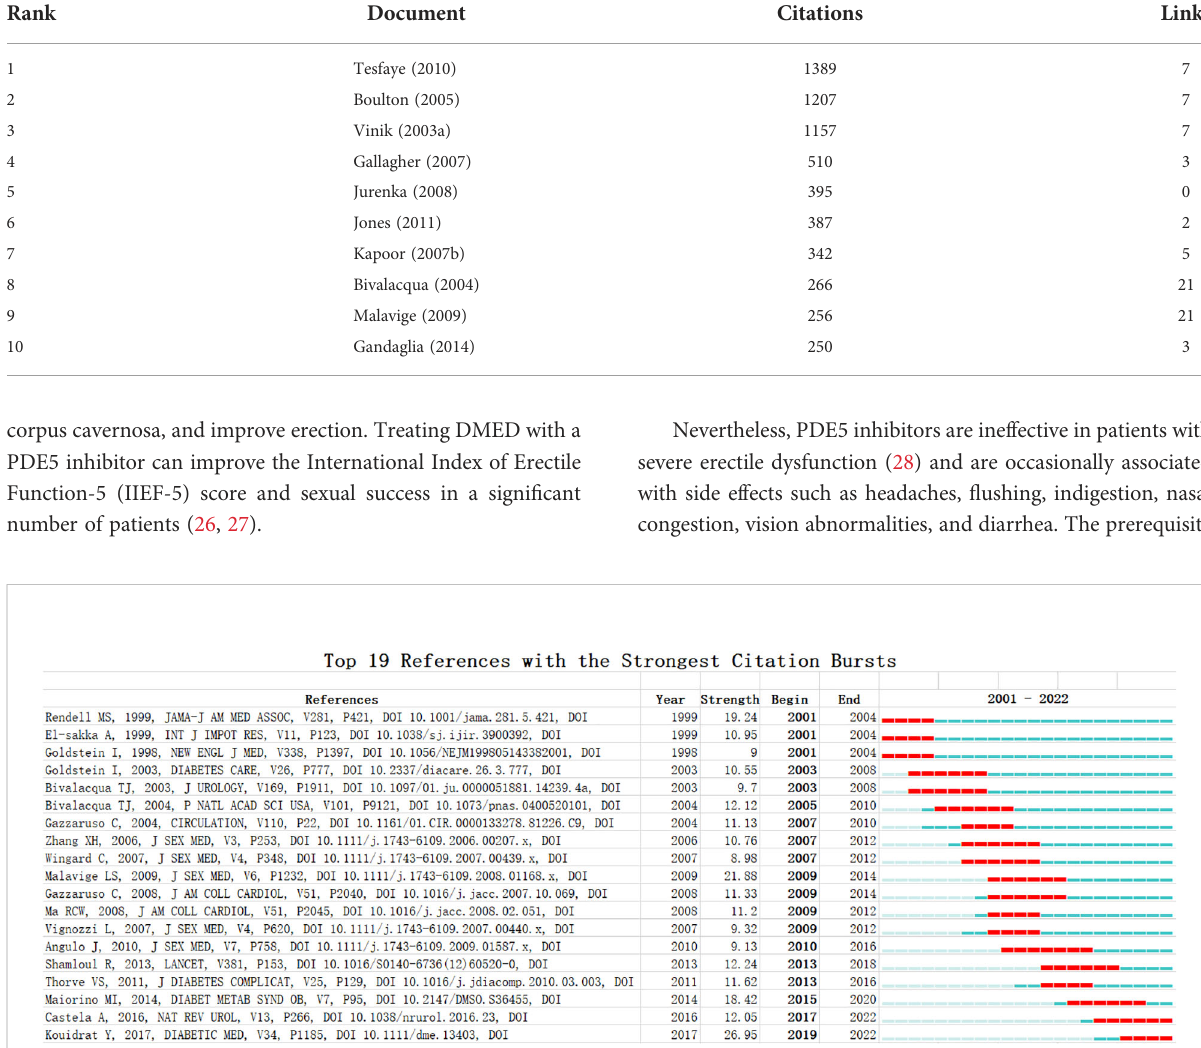
FIGURE 8 The 19 references with the strongest citation bursts.